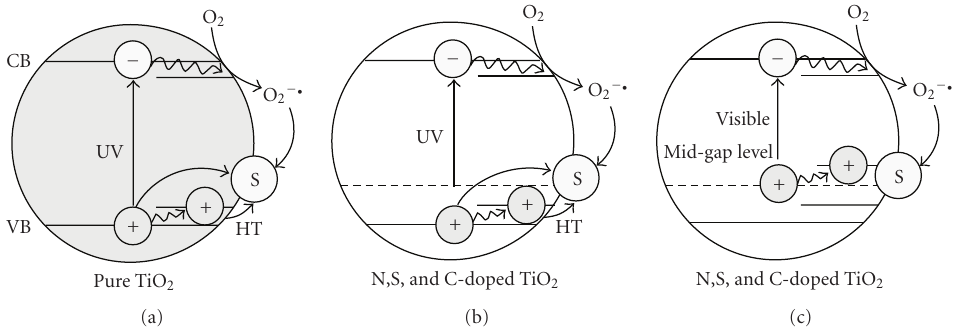
Figure 3: Cartoons illustrating possible photoassisted processes of a substrate adsorbed on the surfaces of pure, N-, S-, and C-doped TiO 2 nanoparticles. Reproduced with permission from [45]. Copyright (2007) American Chemical